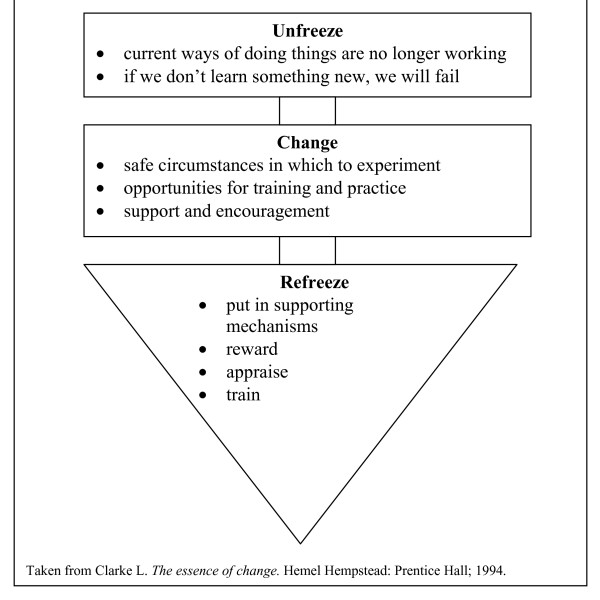
The unfreeze-change-refreeze model.